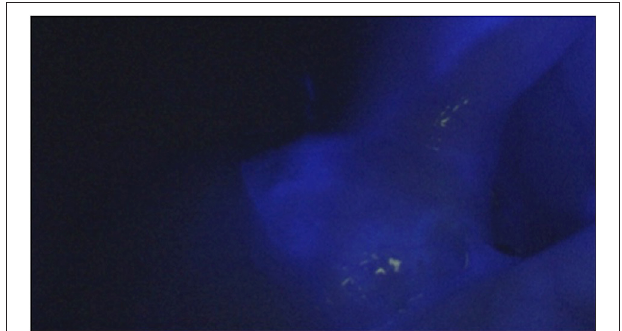
FIGURE 4 | Illumination of the suspected lesion in infrared